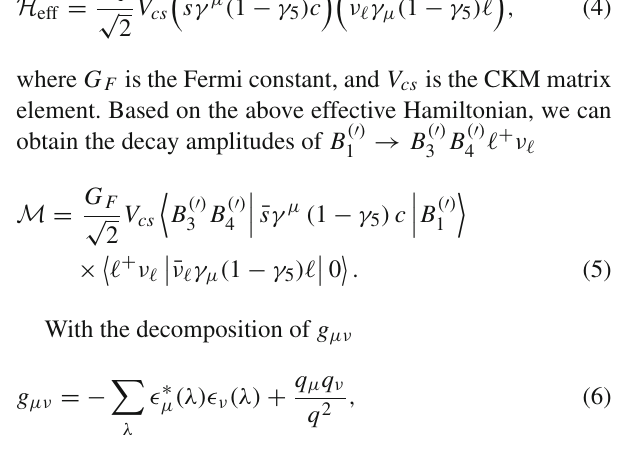
Fig. 1 Feynman diagram of charmed baryon weak decay of B ( (cid:2) ) ( → B ( (cid:2) ) )(cid:2) + ν B ( (cid:2) ) B ( (cid:2) ) 2 3 4